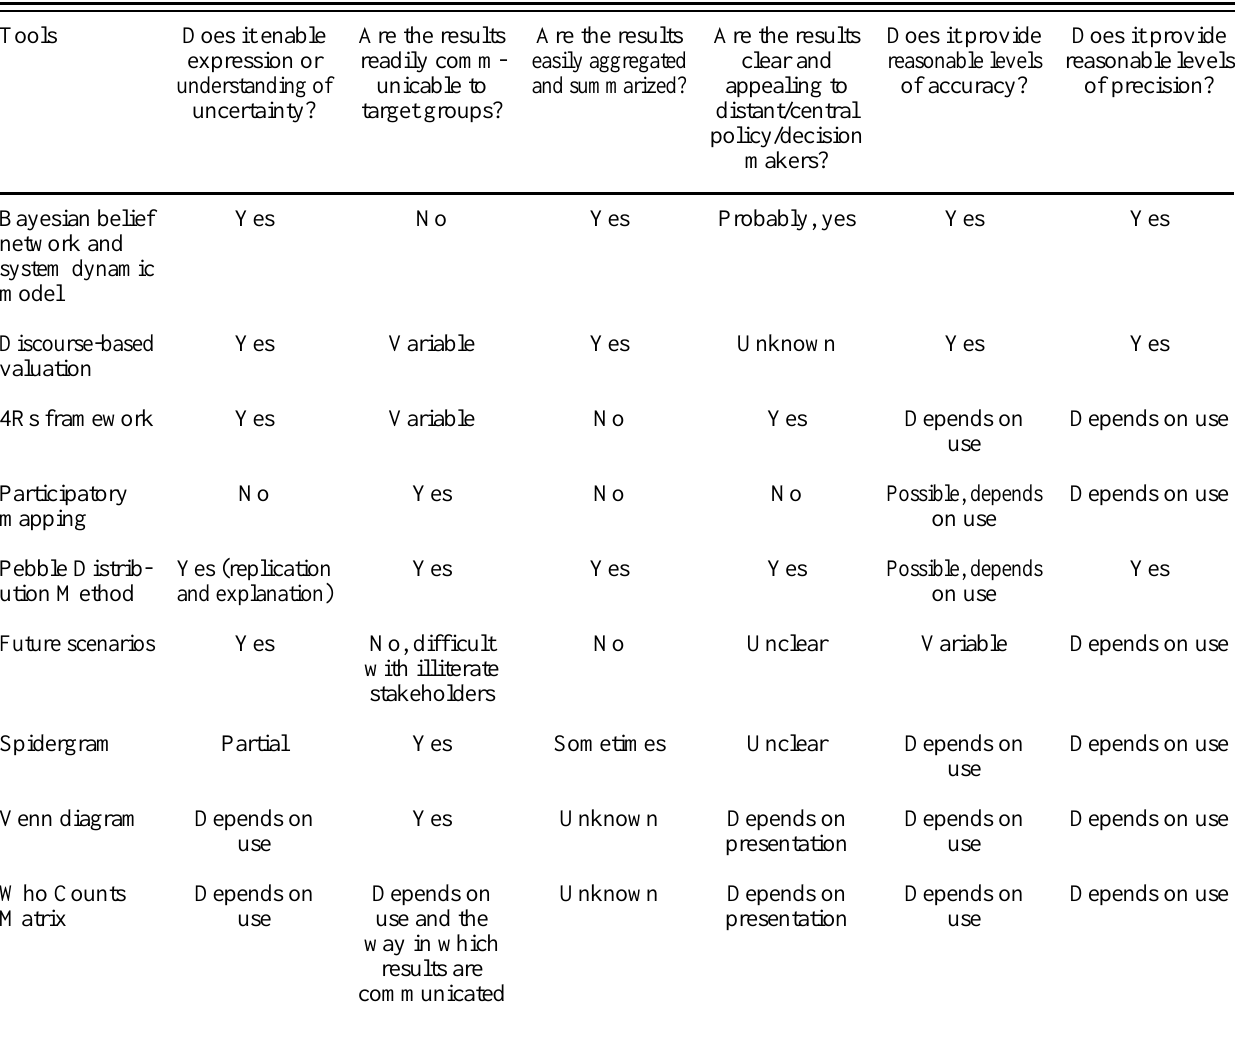
Table 4 . Evaluation criteria for tools grouped into their general capabilities, their use in practice, and the products they generate.